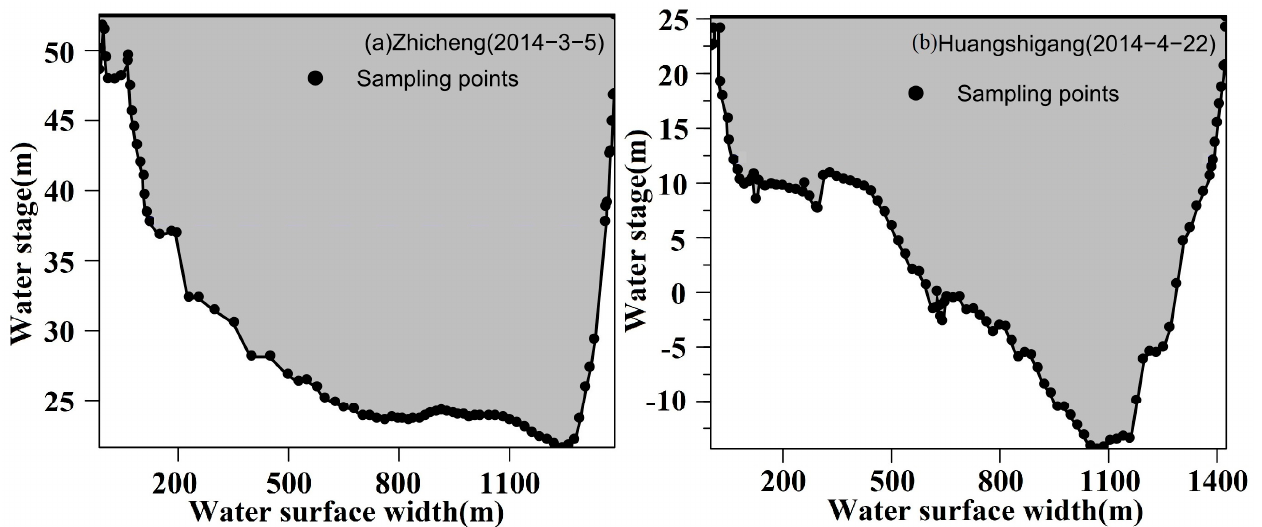
Figure 2. River cross-section at ( a ) the Zhicheng station (left panel) measured on 5 March 2014 and ( b ) the Huangshigang station (right panel) measured on 22 April 2014.